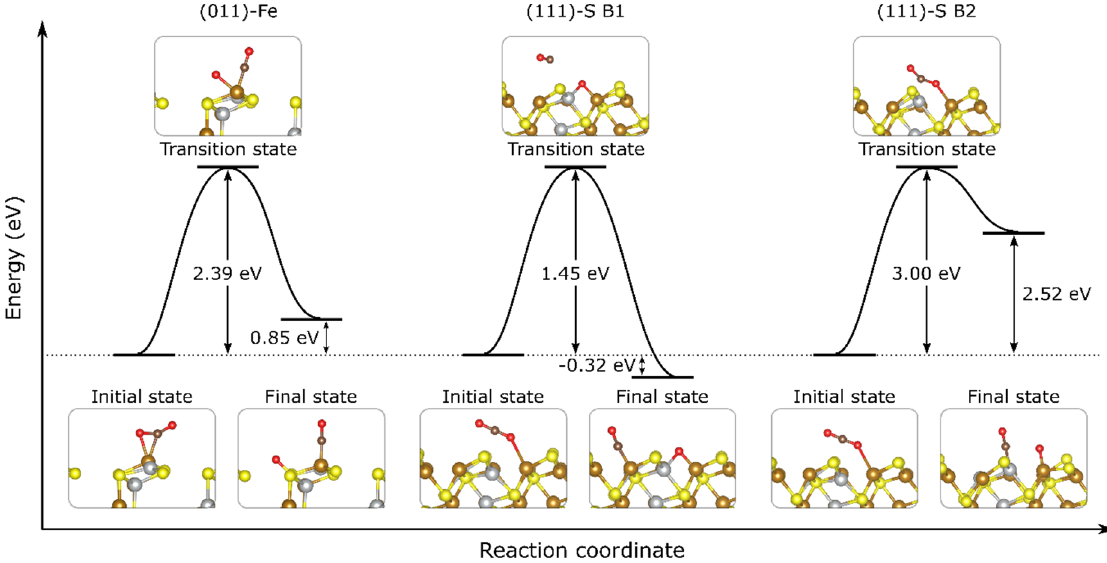
Figure 6. Calculated potential energy profile for CO 2 dissociation on Ni-doped FeS mackinawite surfaces.